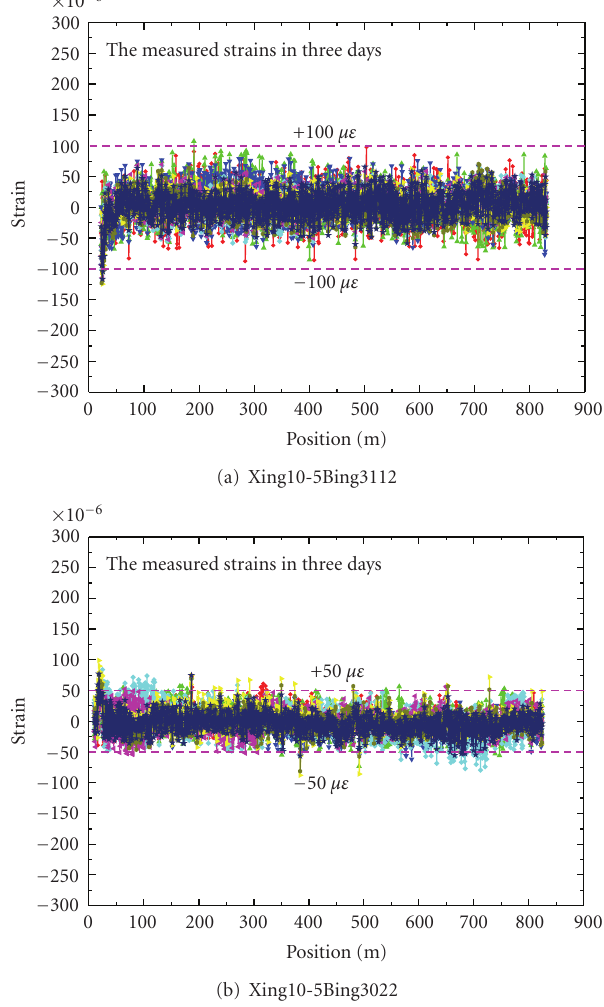
Figure 12: Strain distribution of the casing pipe measured by FRP- OF bar at two oil wells.